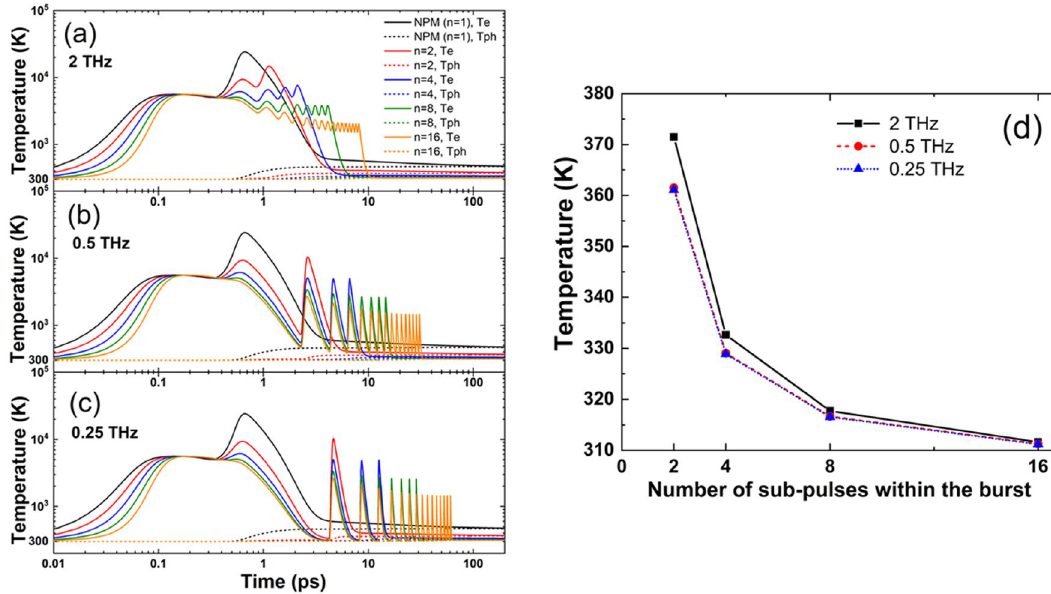
Figure 1. Electron and phonon temperatures at the surface of laser-irradiated silicon obtained with the nTTM with intra-burst frequencies ( a ) 2 THz, ( b ) 0.5 THz, ( c ) 0.25 THz. ( d ) Temperature at the surface z = 0 nm at 200 ps (when thermalization between the electron and phonon system was reached) as a function of the number of sub-pulses within the burst for different intra-burst frequencies.